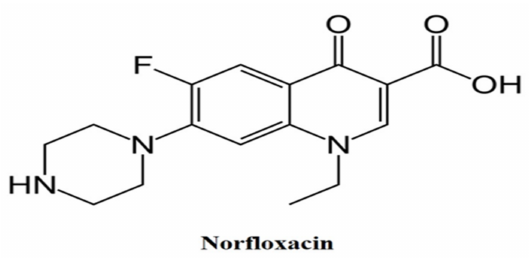
Figure 1. Chemical structure of